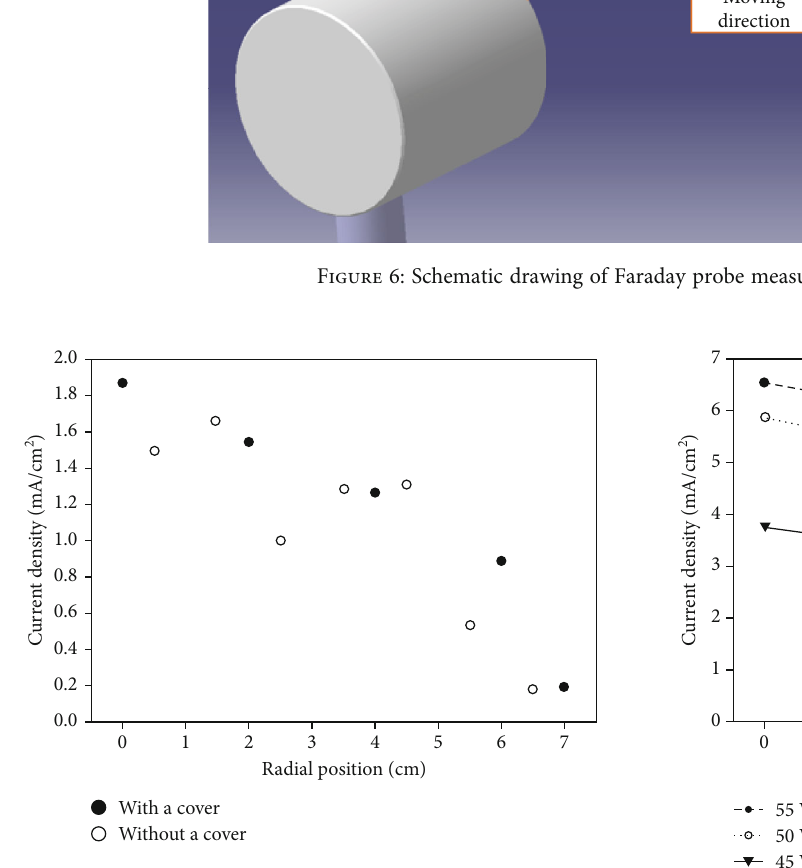
Figure 7: Distribution of current density in the radial position when the engine cover is in use (dot symbol) and when the engine cover is removed (hollow circular symbol).